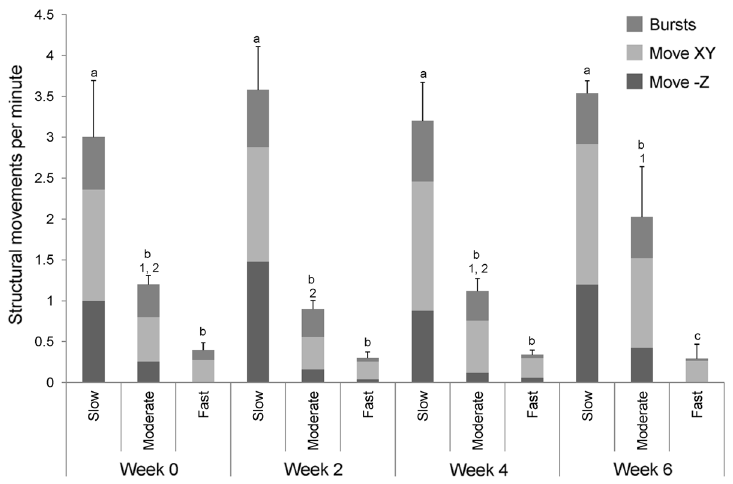
Fig. 1. Mean of structural behaviours per minute in fish at 3 different water current velocities (slow, 0.2 body length [BL] s −1 ; moderate, 0.8 BL s −1 ; and fast, 1.5 BL s −1 ) over 6 wk. Error bars represent SE of total occurrences. Lowercase letters denote significant differences between current veloci- ties, and numbers denote significant differences between weeks based on the cumulated behaviours (p <